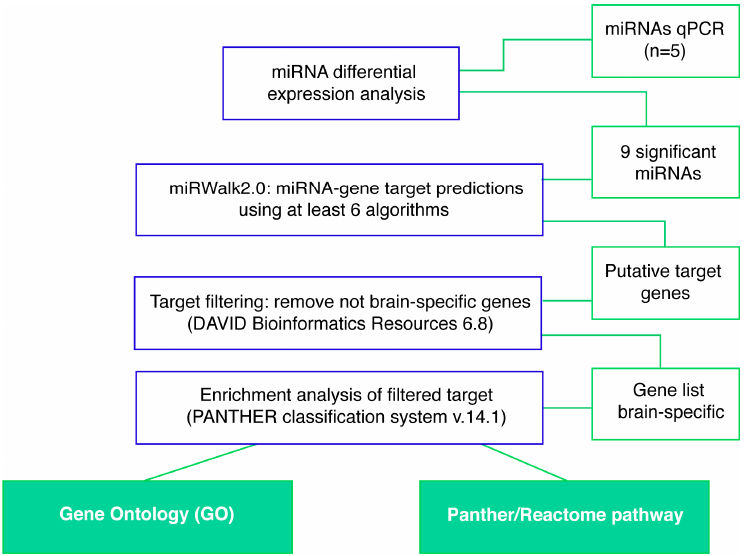
Figure 4. Workflow of the integrative analysis of miRNA-target prediction. The expression data included the dataset derived from miRNA qPCR profiling. Predicted miRNA-target by miRWalk2.0 was filtered for retaining only brain-specific genes and evaluated for gene ontology terms (GO) and specific pathway enrichments (Panther/Reactome).